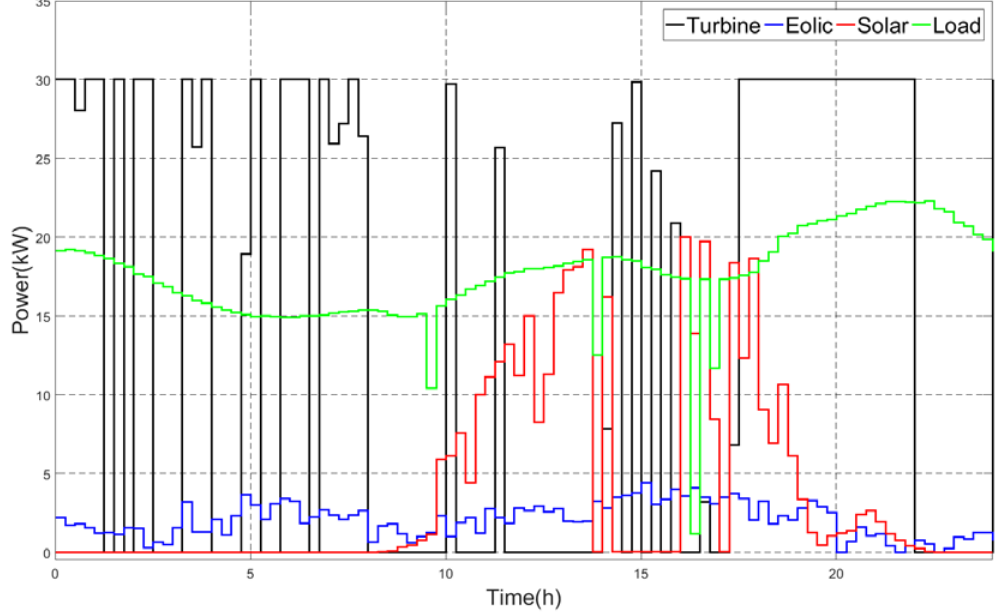
Figure 5. Scenario 1—Generated and demanded power (kW). Microturbine in black, PV panels in red, wind turbine in blue and demand power in green.